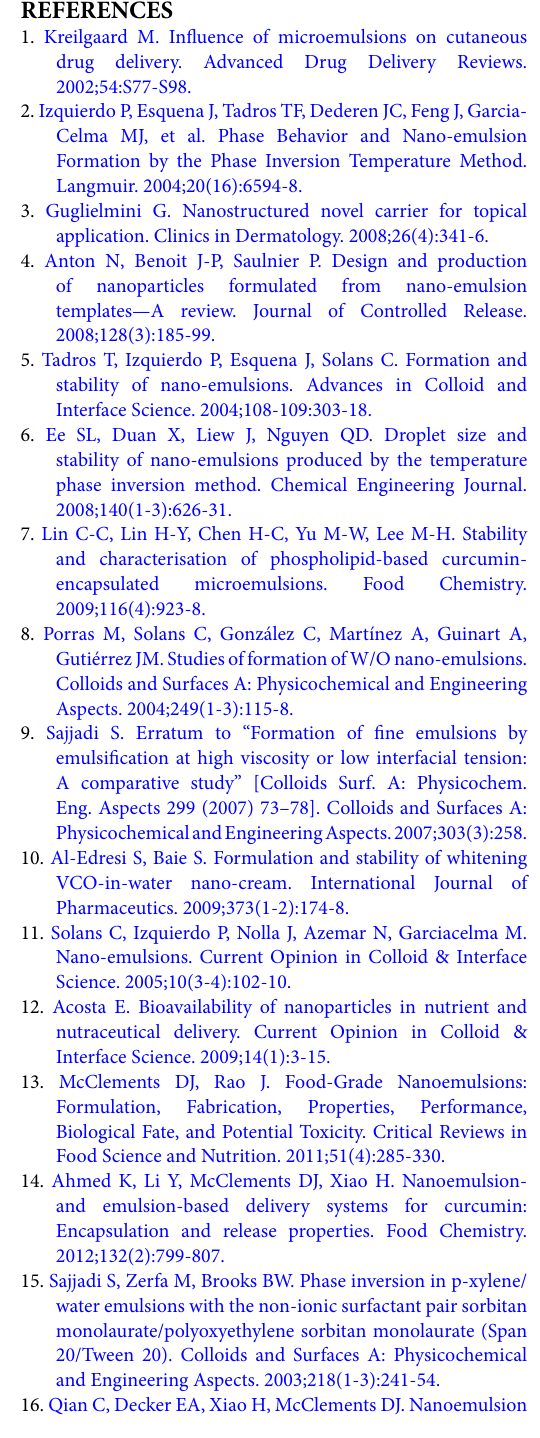
54 Nanomed Res J 4(1): 48-55,